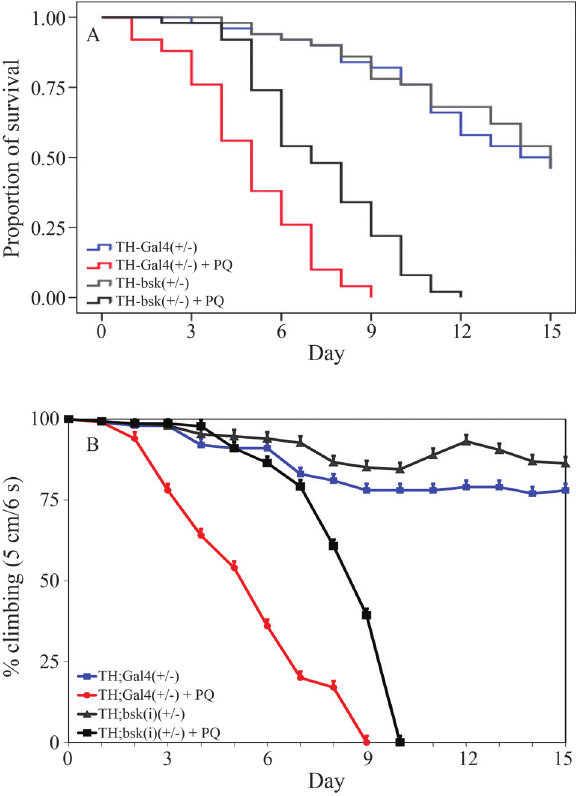
Figure 3 - Basket gene knockdown increases life span and locomotor ac- tivity in Drosophila melanogaster exposed to paraquat. Female flies (n = 50 per treatment) were treated as described in Materials and Methods . The graphs show that the proportion of survival and climbing performance were significantly increased in TH-Gal4 +/- , UAS-bsk RNAi +/- gene knock- down flies compared to the TH-Gal4 +/- fly line (control). Statistical com- parisons between untreated and treated flies showed: (A) a p < 0.05 by log-rank test and (B) a p < 0.05 by (cid:2) 2 test. Comparisons between treated geneknockdownfliesandthe TH-Gal4 +/- flylineshowedstatisticalsignif- icance.